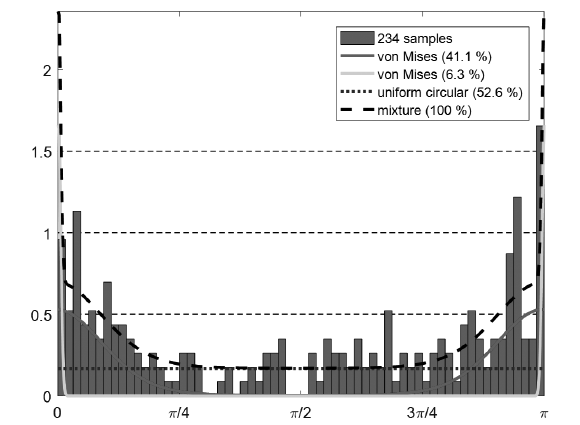
Figure 2. Histogram of observed orientations and estimated pro- bability density functions of the mixture